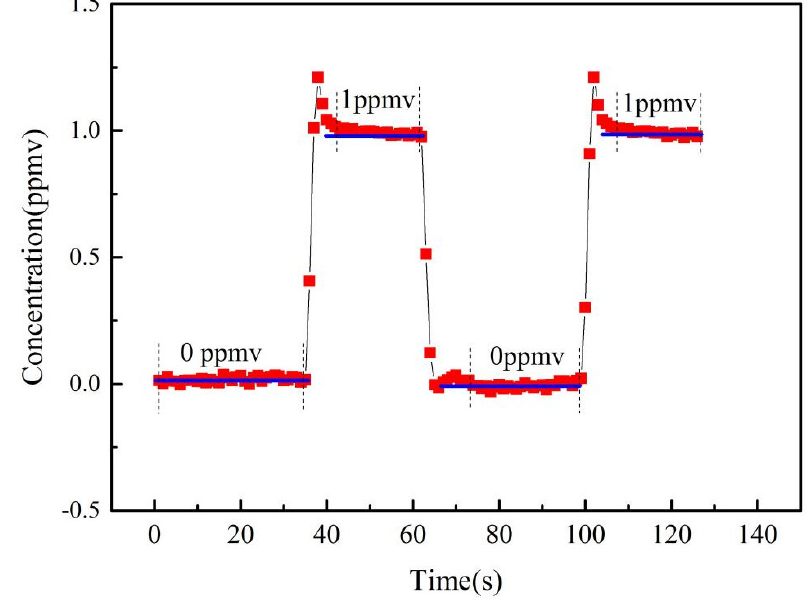
Figure 7. Dynamic measured results of C 2 H 2 sensor.